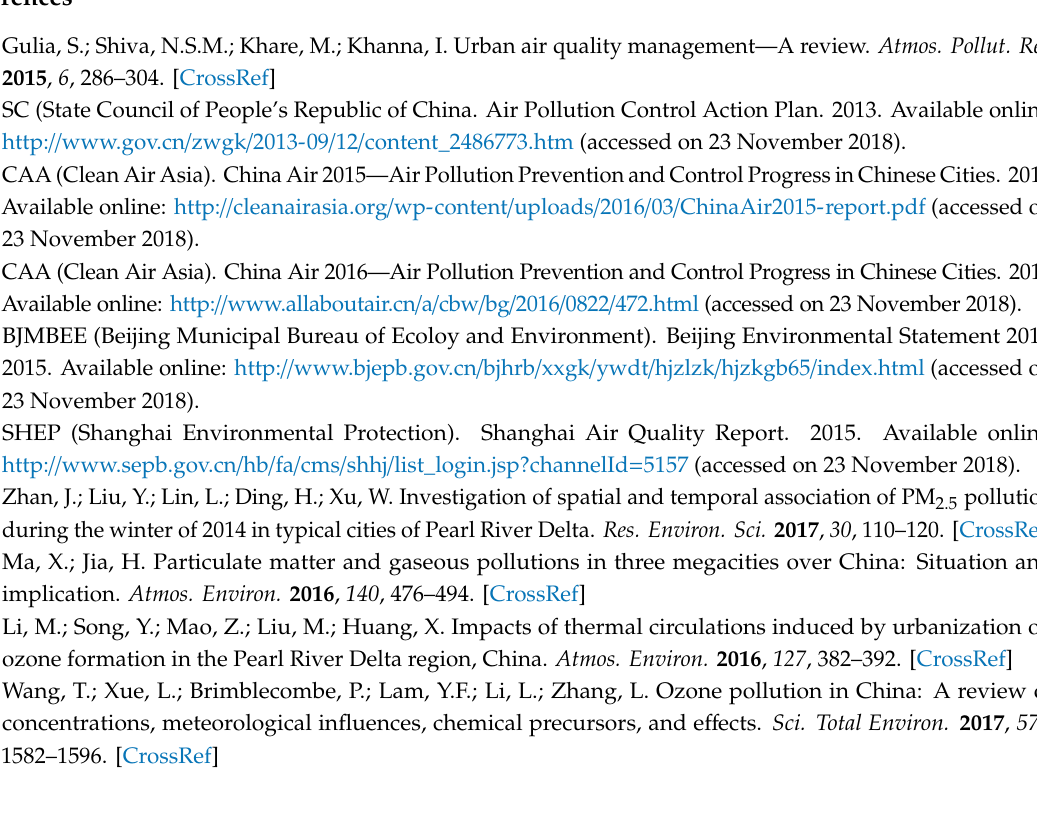
Figure S1: Research framework, Figure S2: WRF-Chem simulation domain, Table S1: Emission sectors, corresponding inventory technical guidelines and special allocation rules, Table S2: Description of emission control scenarios, Table S3: Detailed information for pollution episodes observed in Haizhu monitoring stations, 2015, Table S4: Statistical data for heavy pollution episode in Haizhu district during 14–28 January 2015, Table S5: Statistical data for heavy pollution episode in Haizhu district during 3–8 August 2015, Table S6: Performance statistics for meteorological simulation ( hourly statistical data in October 2015), Table S7: Statistical comparison of model evaluation in this paper and previous